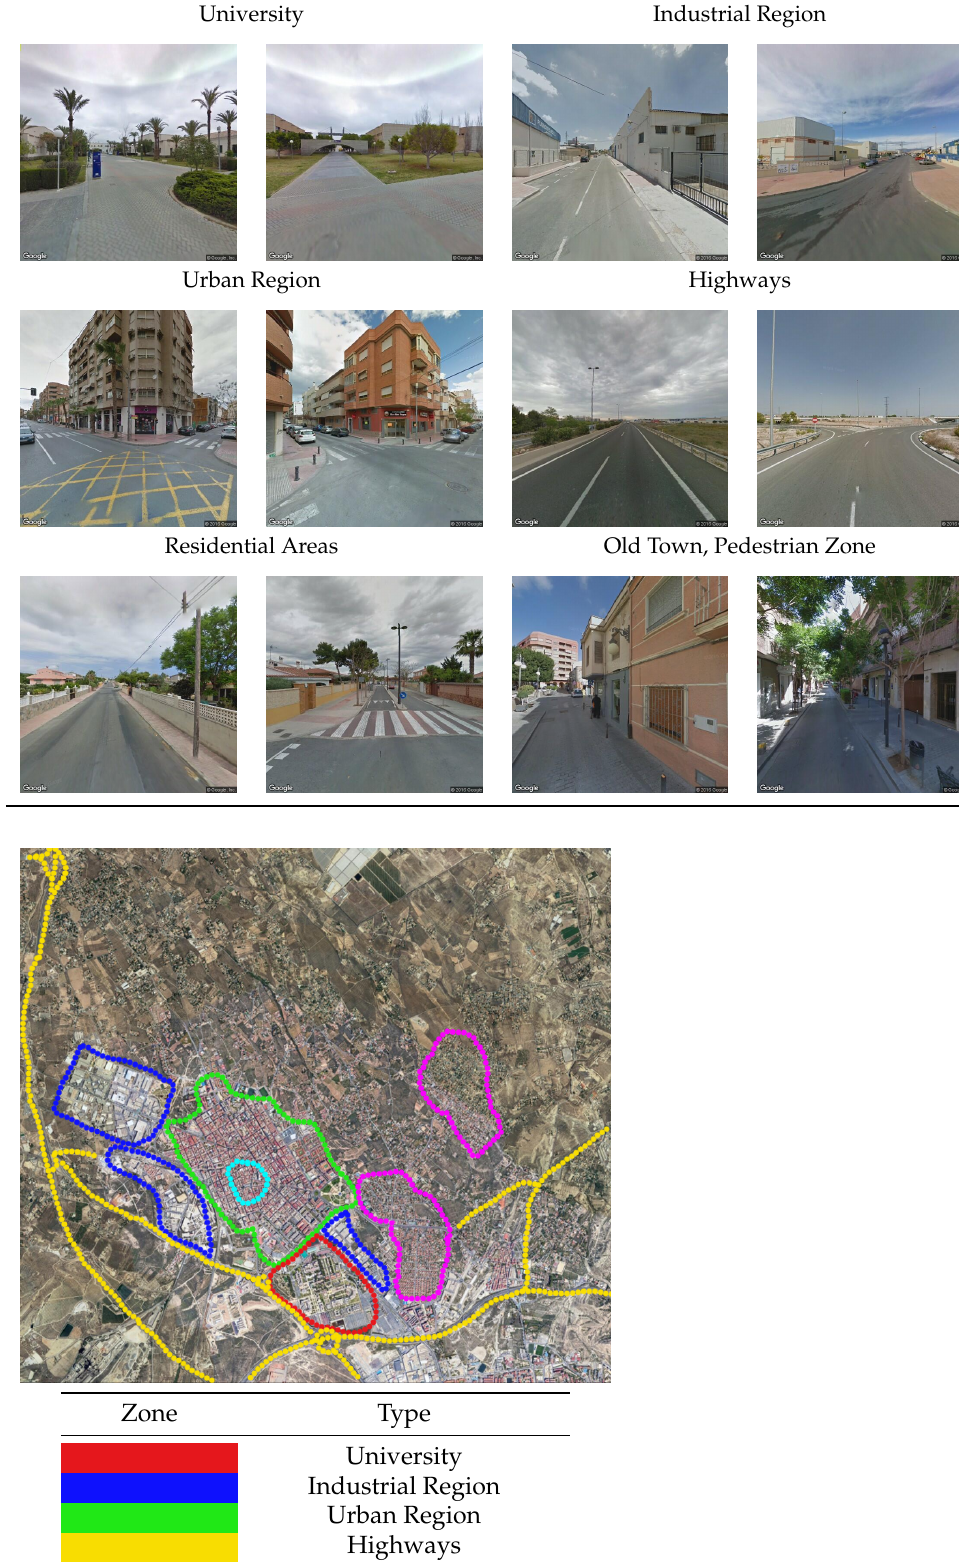
Table 4. Example images belonging to the ground truth regions.